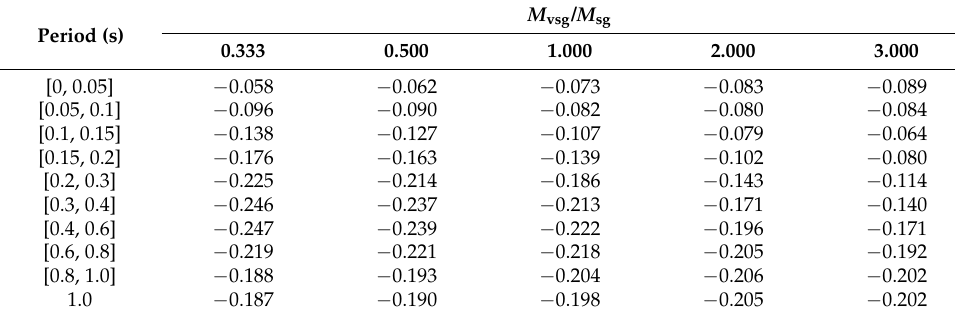
Table A1. Maximum frequency deviations (Hz) ( M vsg was changed).